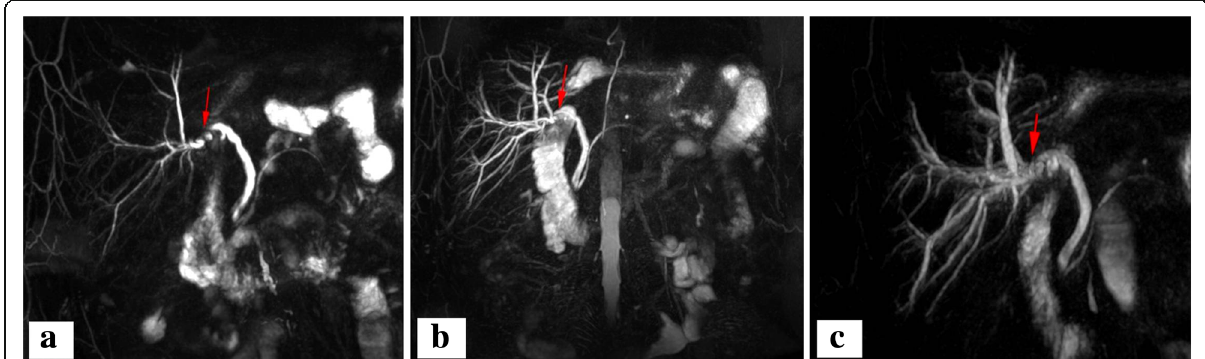
Fig. 5 A 41-year-old male 6 months after liver transplantation with duct-to-duct anastomosis. MRCP 3D MIP reconstructed coronal images showed the presence of anastomotic stricture (red arrow), firstly presented with minimal anastomotic biliary stricture ( a ) reflecting minimal intrahepatic biliary dilatation followed by two follow-up 3 months interval without management revealed biliary stricture progress to mild degree ( b ) and moderate degree ( c )